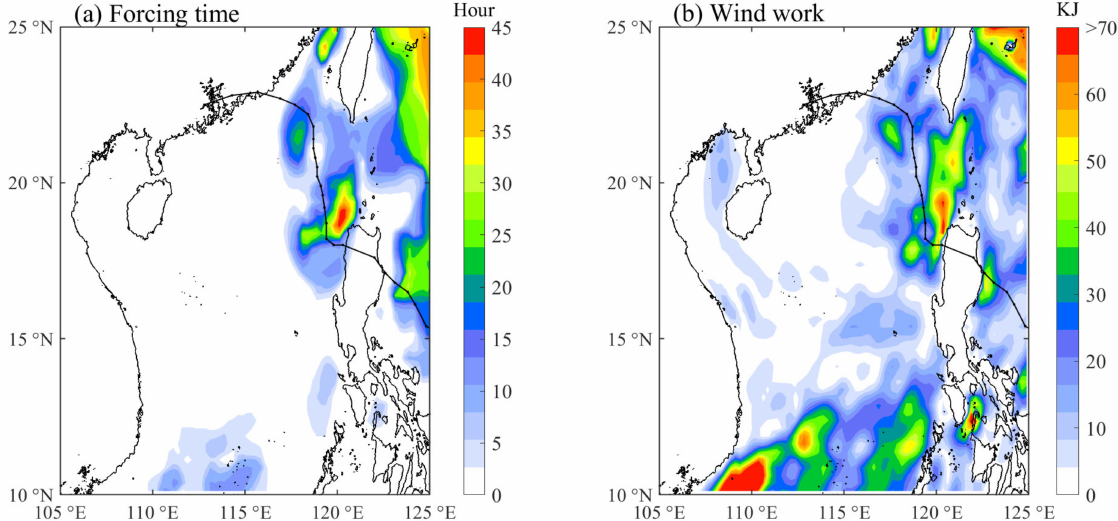
Figure 11. Spatial distribution of forcing time (arrows) and wind work (shading) during typhoon Linfa. The black line denotes typhoon path.